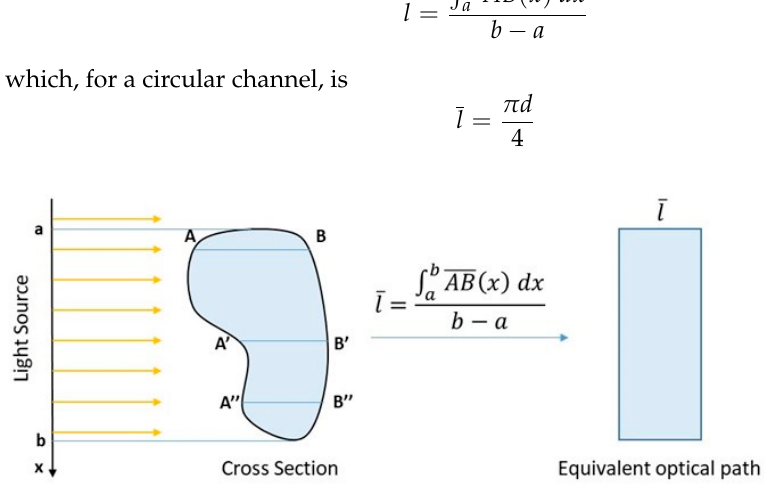
Figure 2. Geometric representation of the mean equivalent optical path.